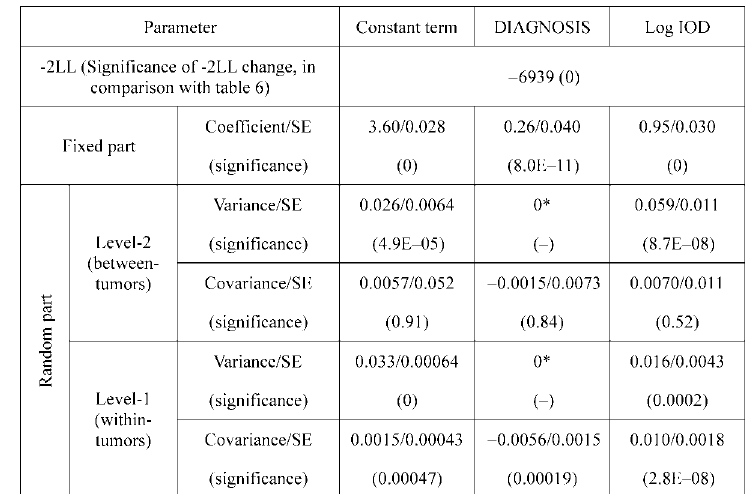
Model for log NA with DIAGNOSIS and IOD as random coefficient covariates